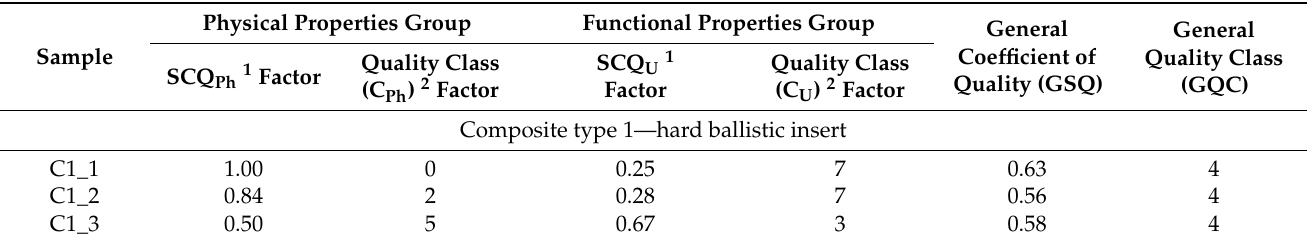
Table 8. Selection of the optimal variants of the para-aramid hard ballistic inserts.